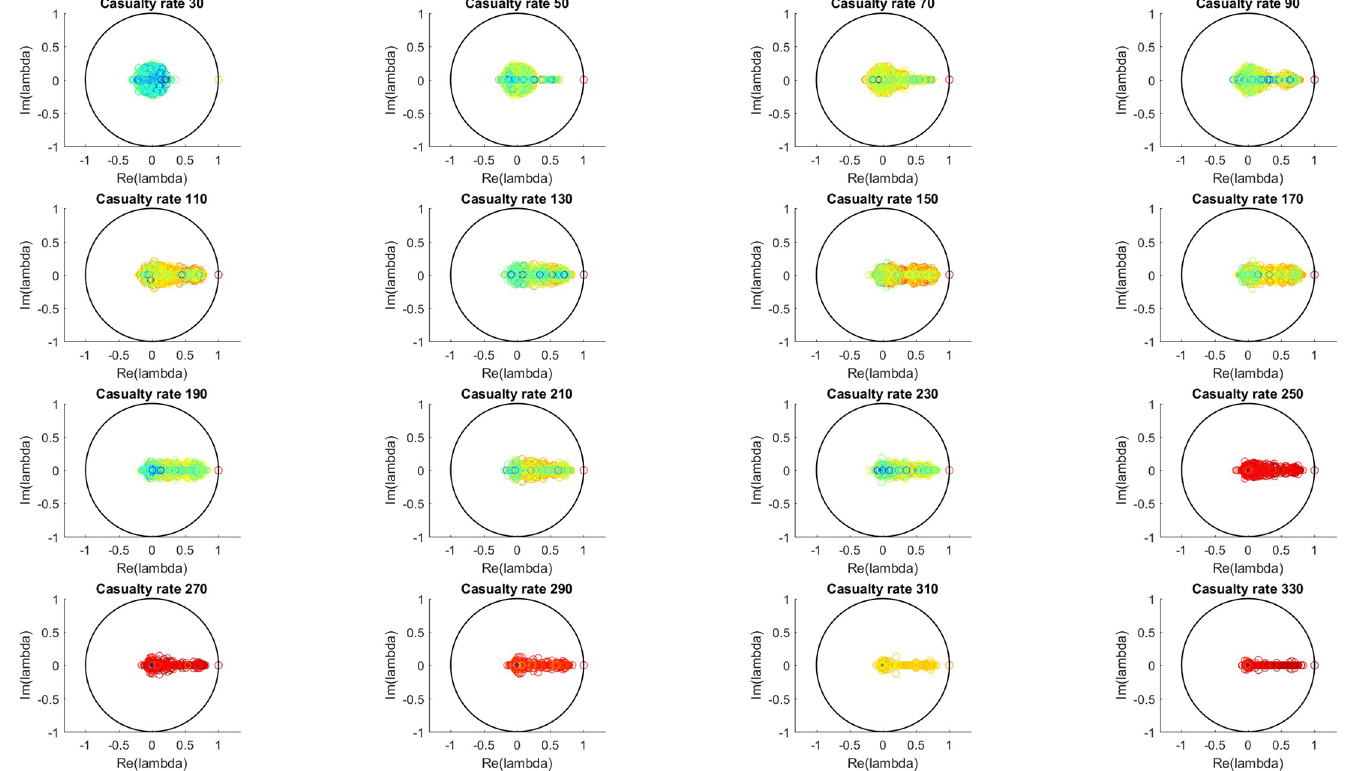
Fig 5. All eigenvalues for all simulations for each casualty source rate. The color scale (blue to red) indicates the L-2 norm of each eigenvalue’s associated Koopman mode. The transition from damped behavior at low casualty source rates to less damped behavior at higher casualty source rates is apparent in the shift in the eigenvalue distribution from clustering around the origin to collapsing onto the real axis and approaching the unit circle.